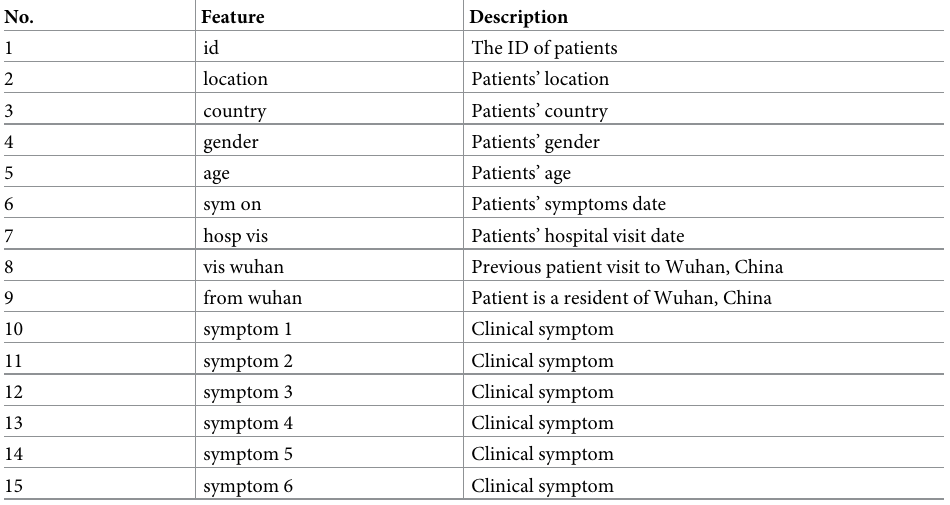
Table 14. COVID-19 dataset description.